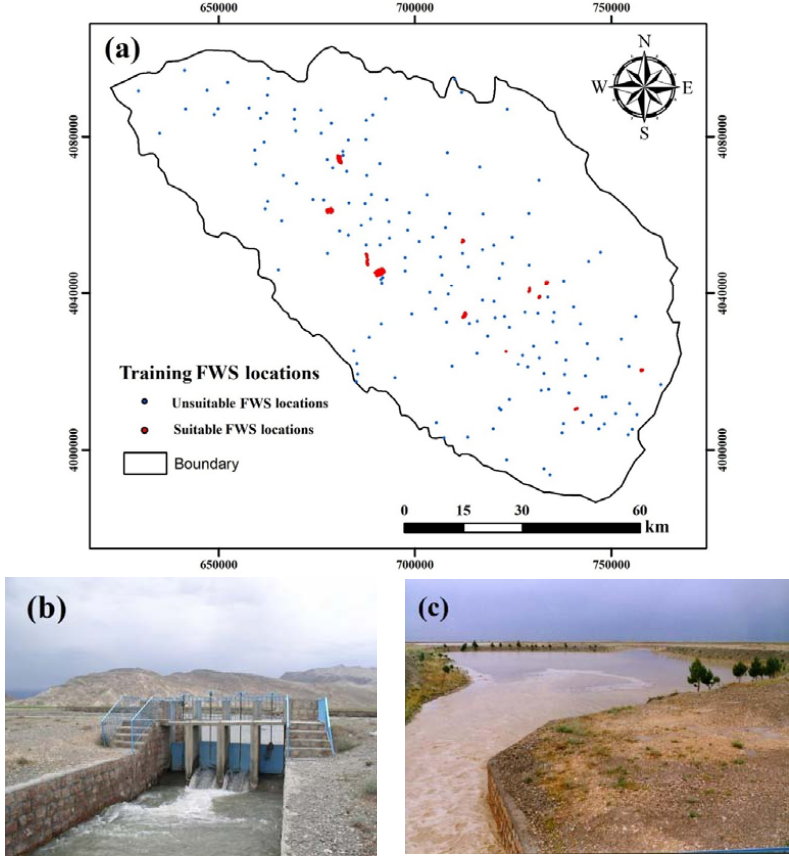
Figure 4. ( a ) The location of the FWS suitable and unsuitable areas, ( b ) the diversion dam of the Jamab FWS system, and ( c ) the infiltration pond.